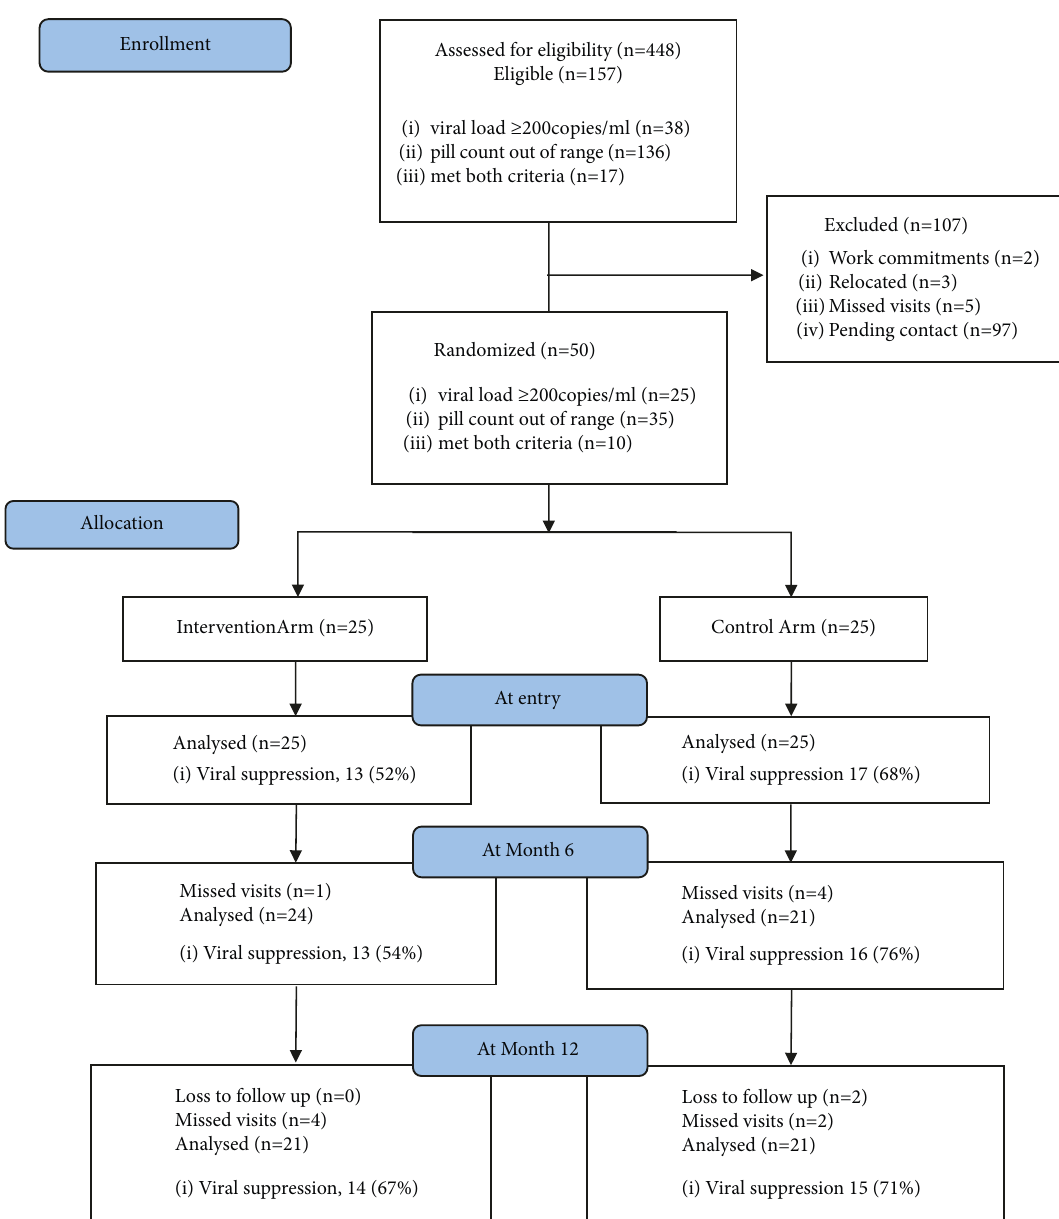
Figure 1: Summary of participant flow and viral suppression